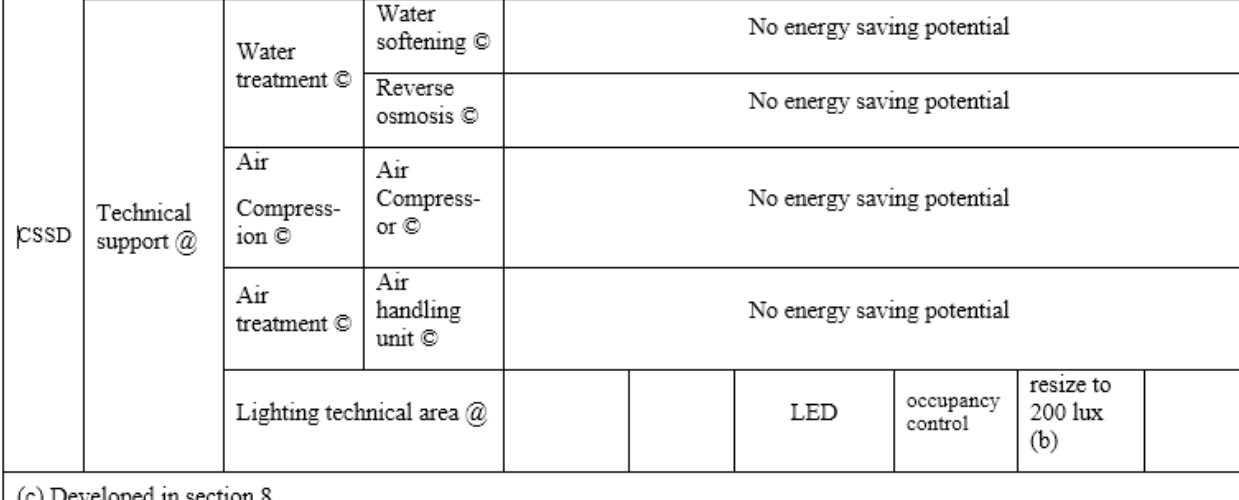
Figure 9. Matrix of proposed energy-saving measures - packing sterilization, sterile storage and technical support zones - CSSD- University hospital.